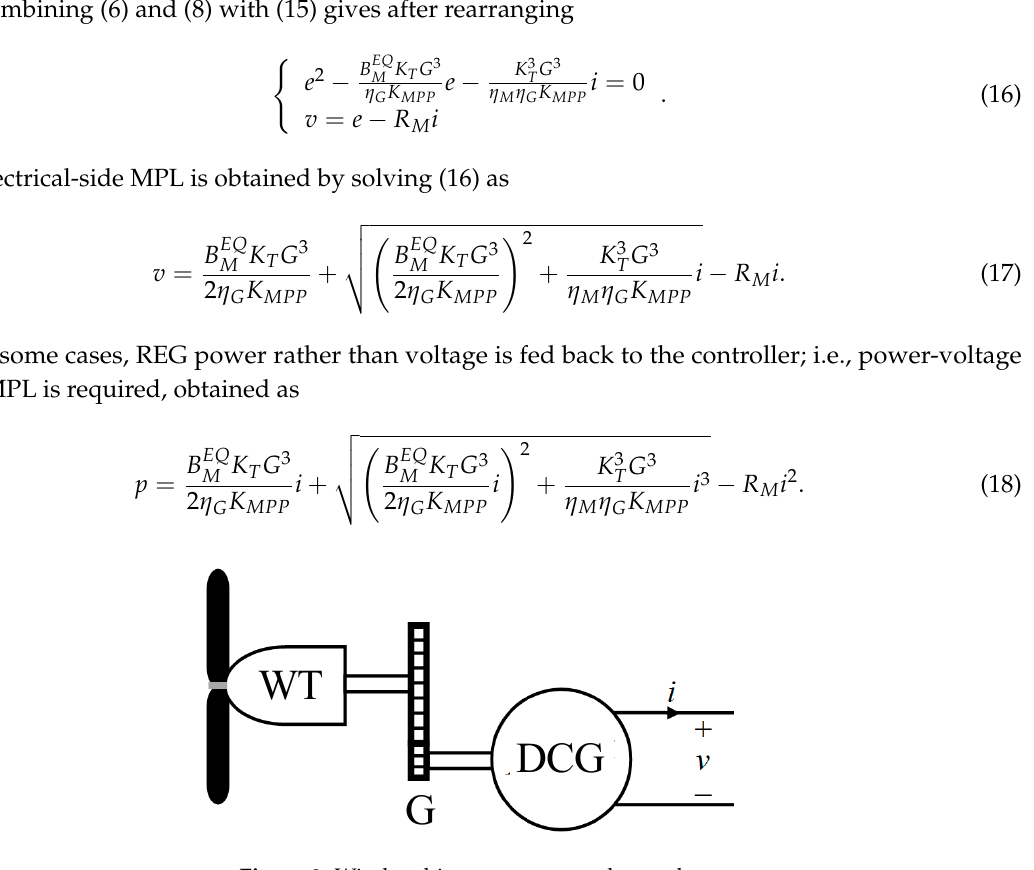
Figure 3. Wind turbine generator under study.